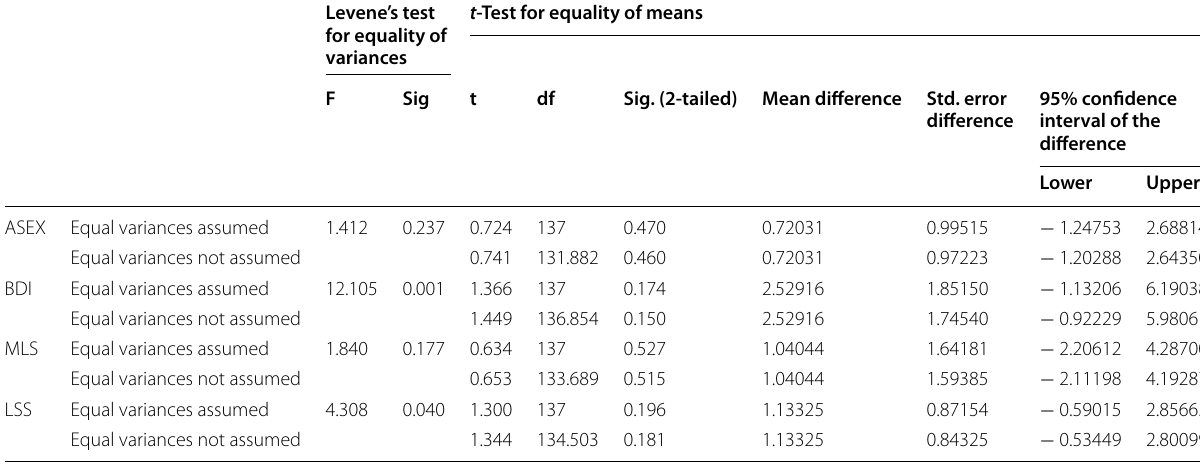
Table 6 Independent samples test for ASEX